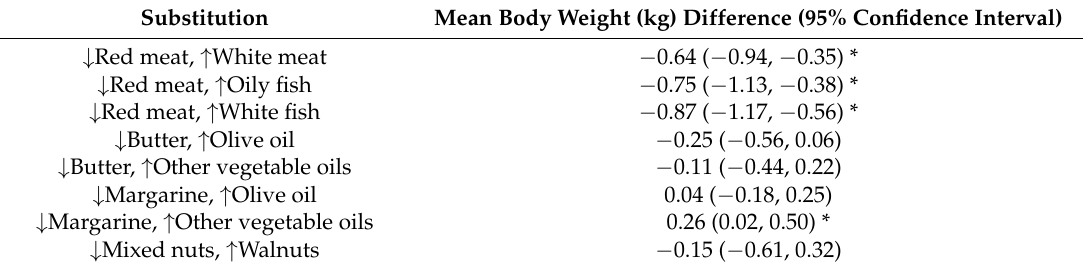
Table 4. Estimated mean changes in body weight (kg) (95% confidence interval) 1 after substitution of one daily portion of high-fat food items in the MeDiet for a priori healthier